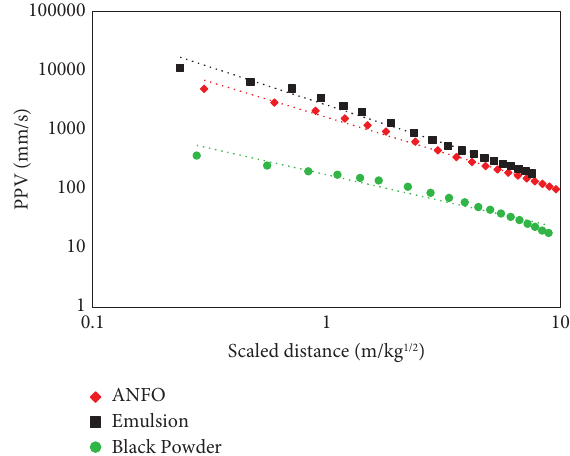
Figure 11: The peak particle velocity diagram versus the scaled distance for different explosives.